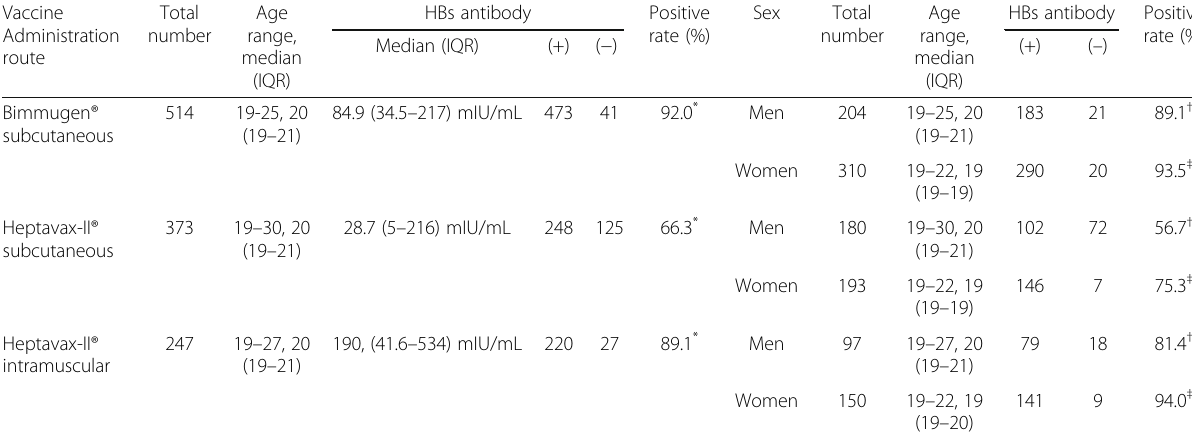
Table 2 Positive rate of HBs antibody after HB vaccination Vaccine Administration